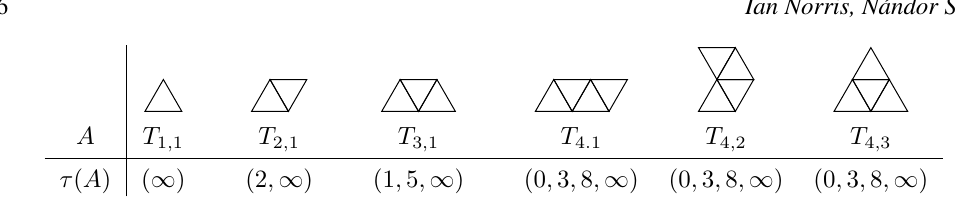
Figure 5: Polyiamonds and their threshold sequences up to size